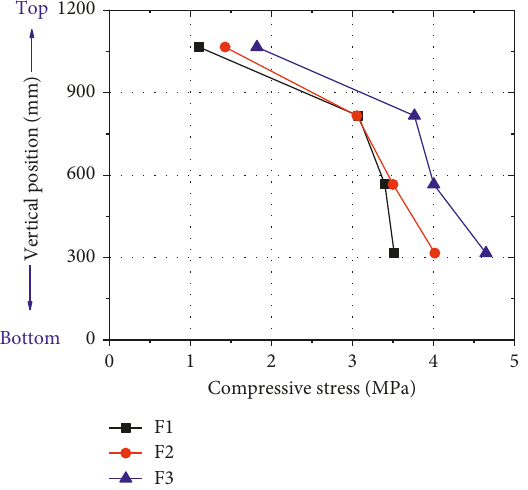
Figure 11: Stress distribution of the concrete structure.